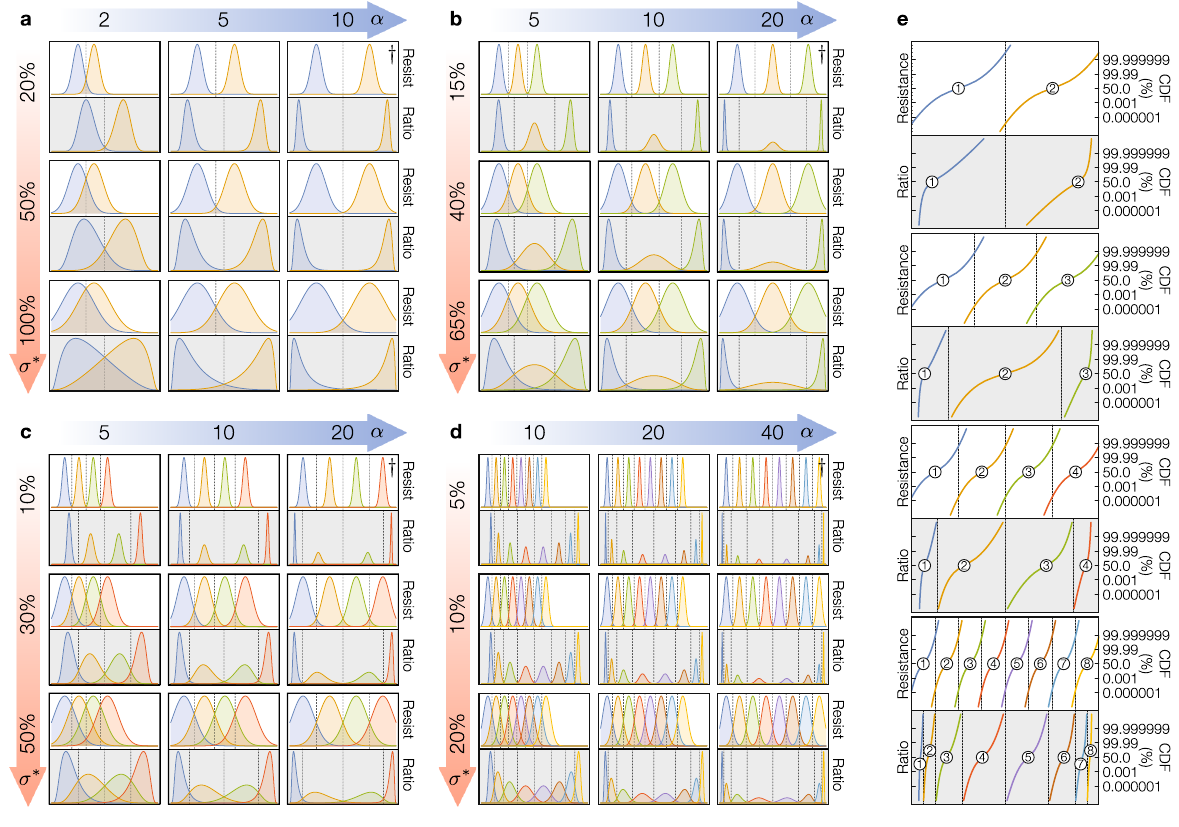
Figure 4. Multi-level state distribution under different parameters. ( a ) Two-level cell with α in [2, 10] and σ ∗ 20%, 100% in . ( b ) Three-level cell with α in [5, 20] and σ ∗ in [ ] 10%, 50% and σ ∗ in . ( d ) Eight-level cell with α in [10, 40] and σ ∗ in [ ] function (CDF) of the states for configurations marked with a † in ( a – d ) (in the right-top corners). In all cases, the optimal thresholds between states are marked with dashed vertical lines, and for a given configuration of n , α and σ ∗ , the top part uses ReBE and the bottom part RatioBE (on a grey